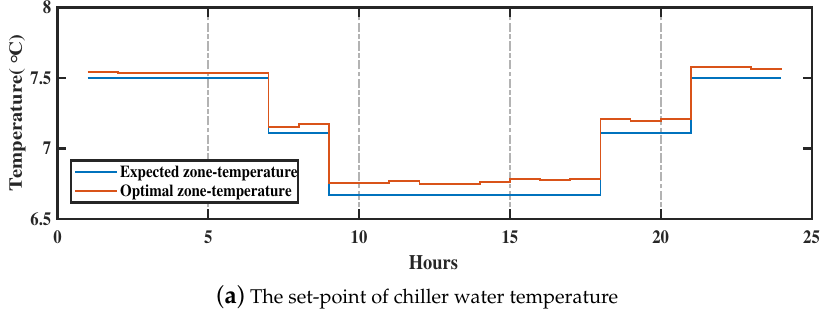
Figure 11. The set-point of temperature for the scheduling of one day.